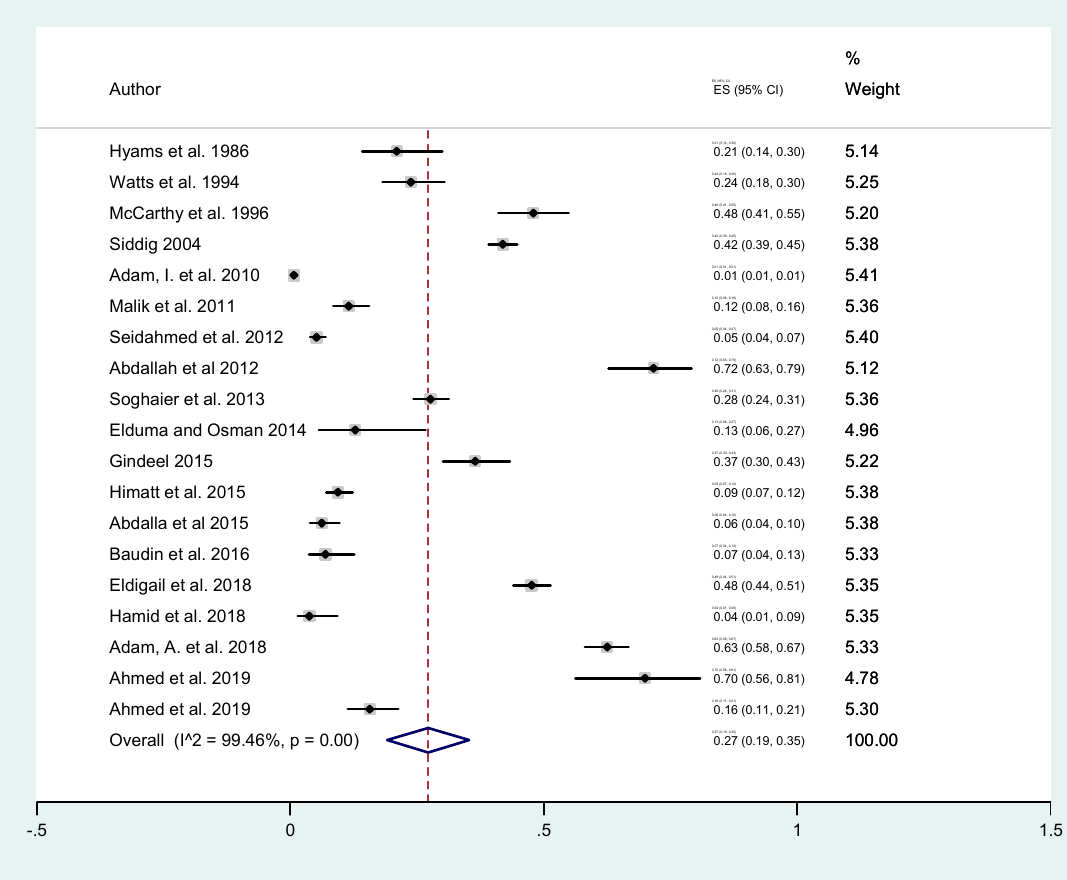
Overall (I^2 = 99.46%, p =